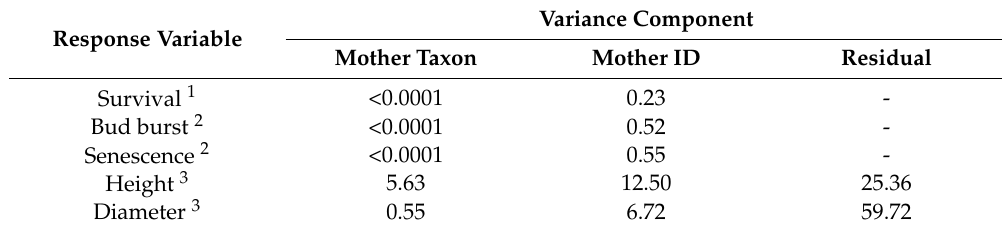
Table 5. Variance components calculated in the different models for the taxon of the mother tree (Mother taxon), the individual mother tree (Mother ID), and the residual variance. Only linear regression models have a calculation of the residual